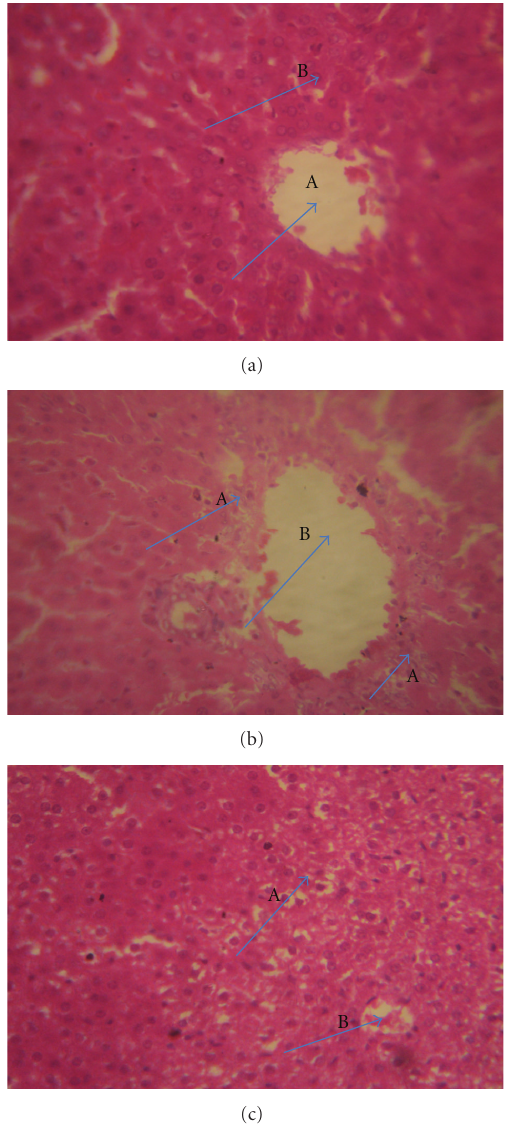
Figure 2: (a) The micrograph of the kidney section obtained from first filial control rats, magnification × 400. (A) Normal glomerulus. (b) The micrograph of the kidney section obtained from first filial rats treated with fixed-dose combined antituberculous agents, mag × 40. (A) Acute tubular necrosis. (c) The micrograph of the kidney section obtained from first filial rats treated with fixed-dose combined antituberculous agents plus vit C, mag × 40. (A) Acute tubular